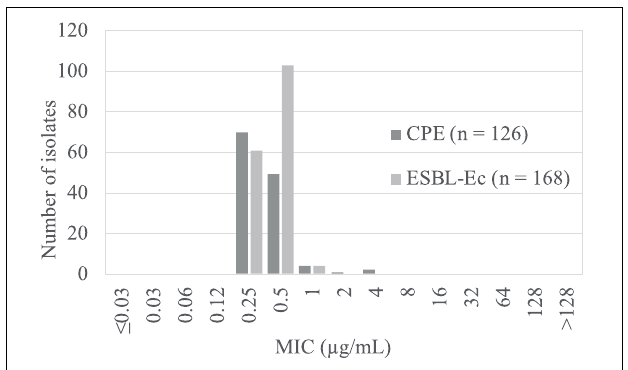
FIGURE 1 | Results of colistin susceptibility testing in carbapenemase- producing Enterobacteriaceae (CPE, dark gray) and ESBL-producing Escherichia coli (ESBL-Ec, light